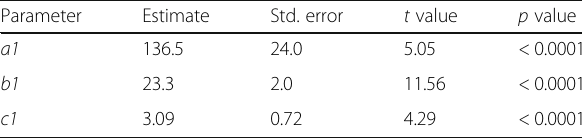
Table 5 Parameter estimates for sub-model 1. The model pre- dicts breast height wood density in ring 30 from pith ( D 30 ) from mean annual temperature (MAT) and soil C/(N − 0.014), and was fitted to Douglas-fir data from 32 sites throughout New